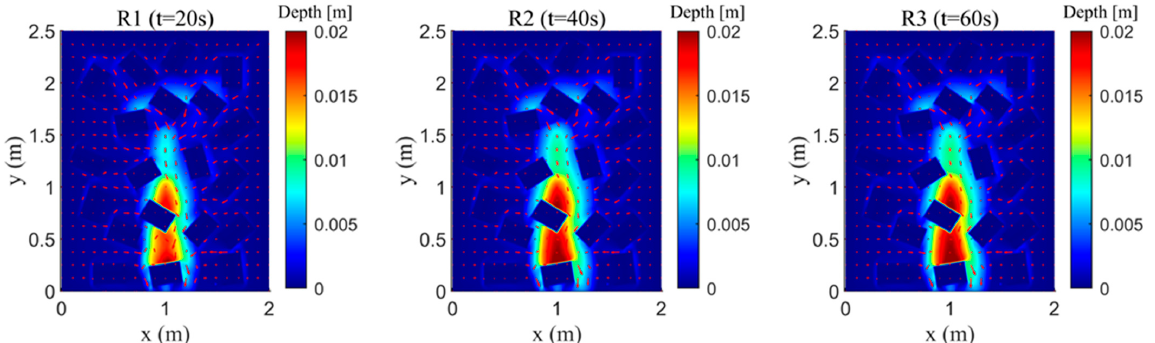
Table 2. Urban rainfall-runo ff experiment: rainfall schemes. Figure 11. Urban rainfall-runoff experiment: simulated water depths and flow patterns at the last